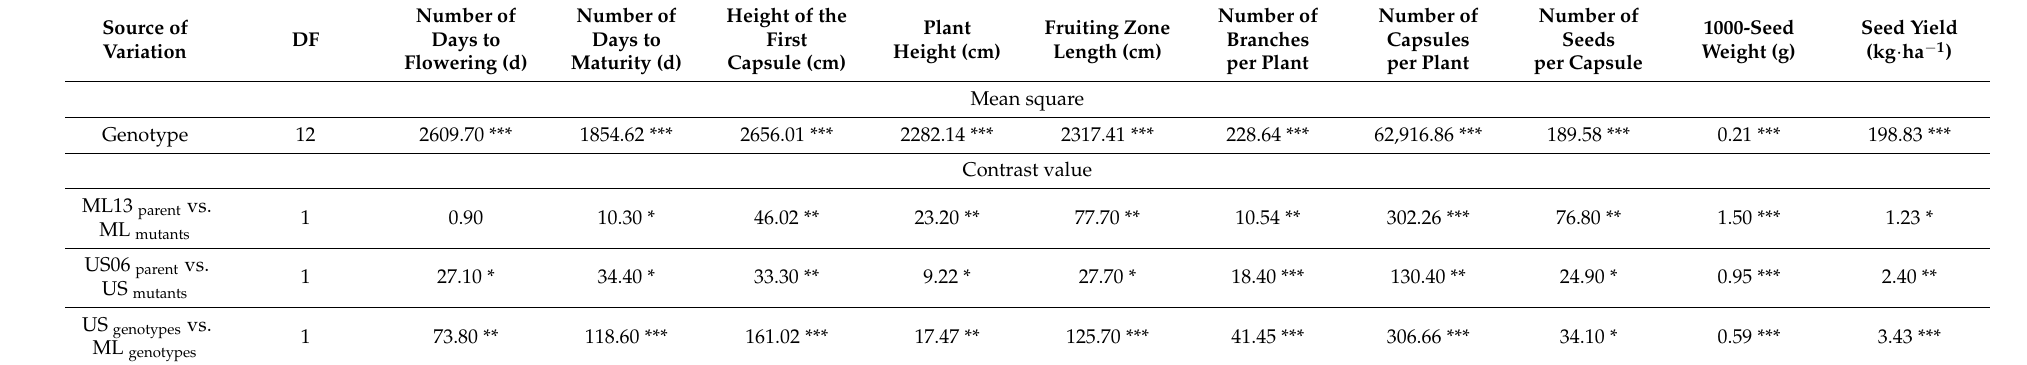
Table 4. Results of analysis of variance of 13 sesame genotypes (11 mutant lines and their two parents) evaluated for various traits (mean square, the value of contrast, and level of difference